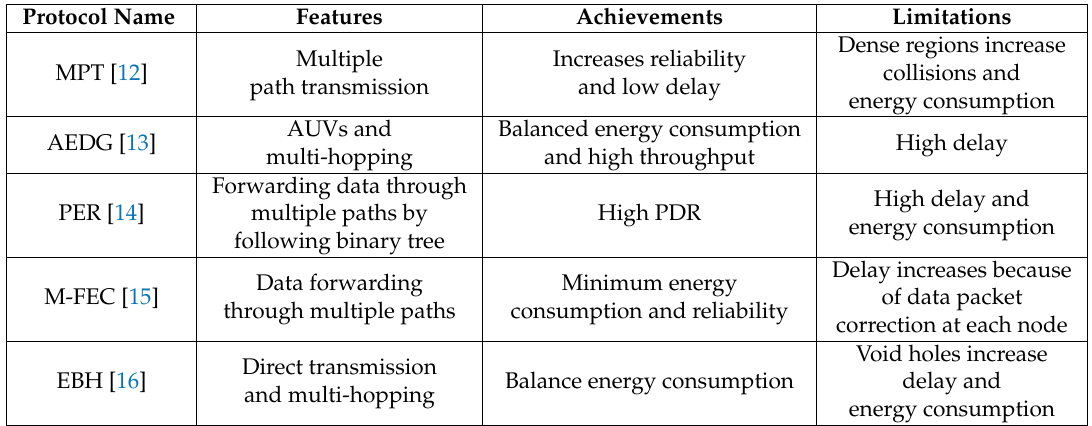
Table 2. Comparison of Multi-Path Routing